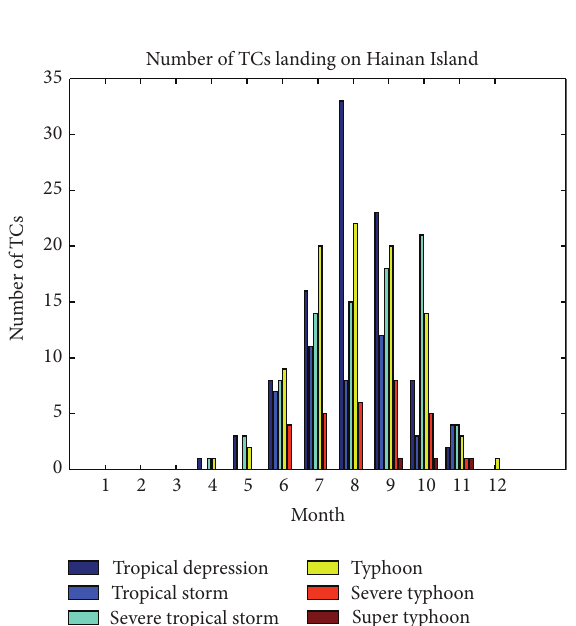
Figure 1: The yearly statistical result.